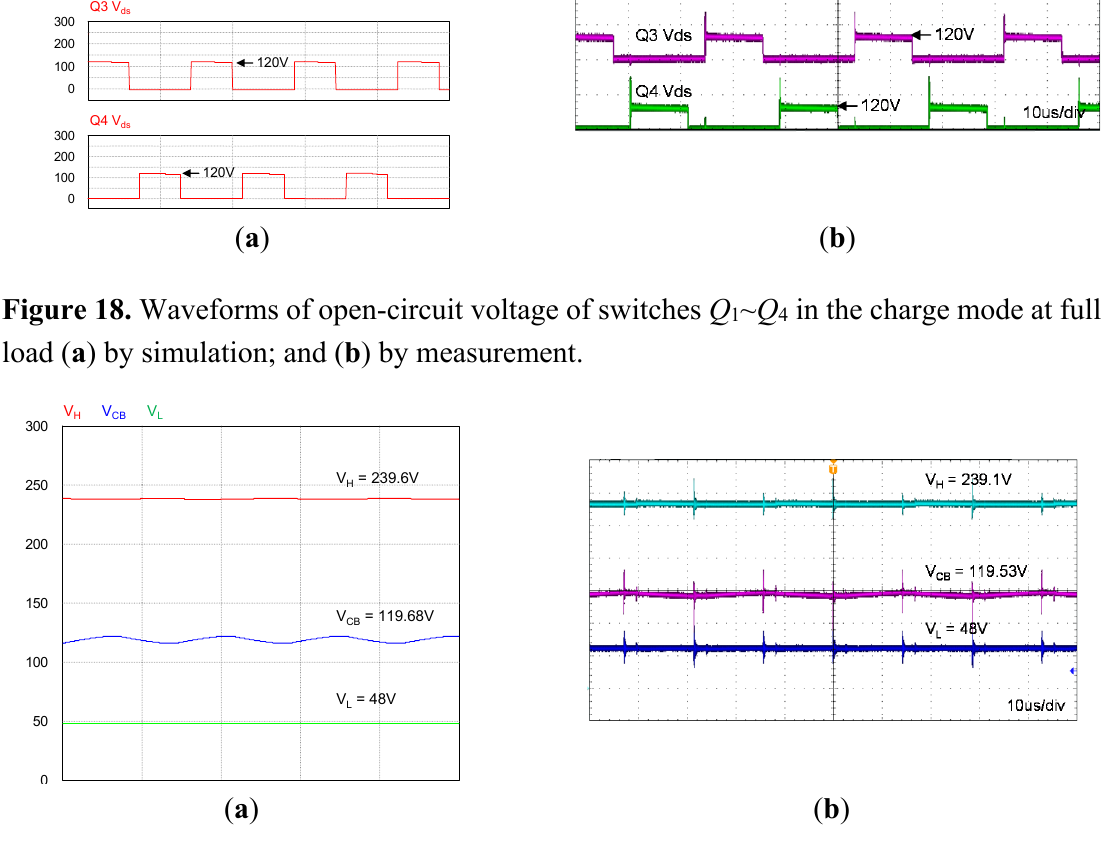
Figure 19. Waveforms of input voltage, output voltage and charge-pump capacitor voltage in the discharge mode at full load ( a ) by simulation; and ( b ) by measurement.